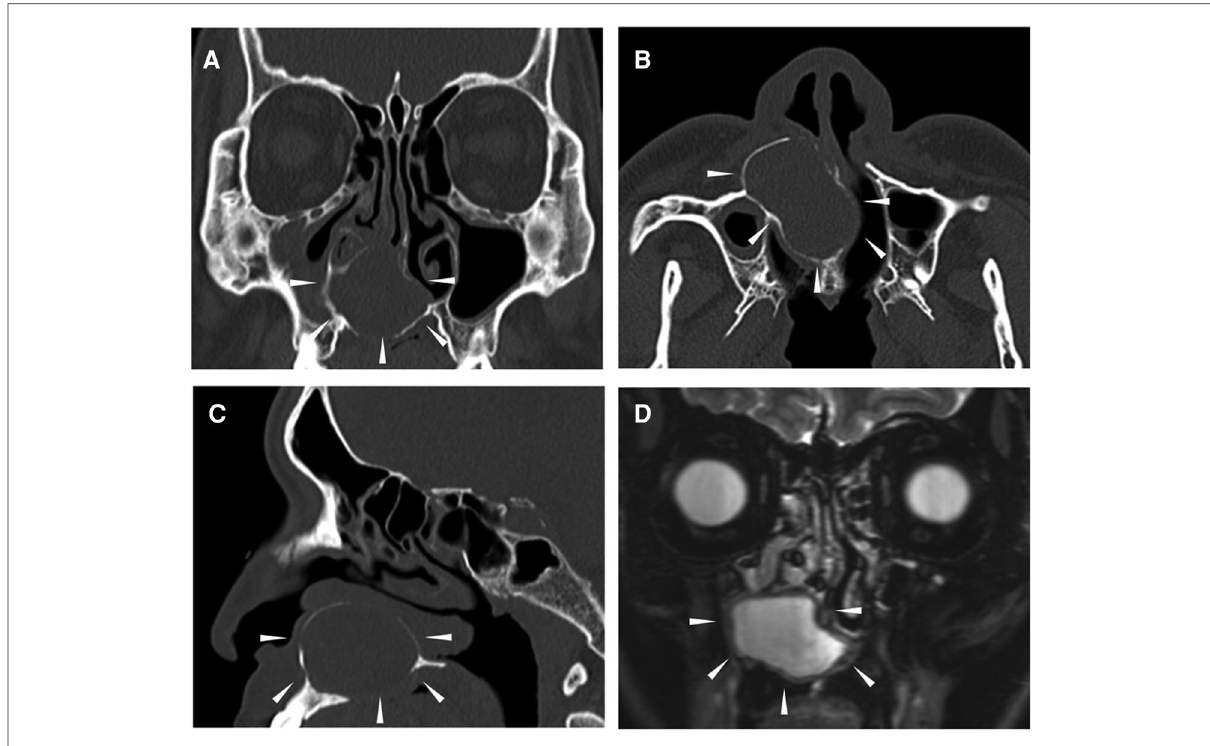
FIGURE 1 Preoperative CT scans and T2-weighted MRI of the sinuses. The area surrounded by the arrowhead indicates the lesion. ( A ) Coronal CT, ( B ) Axial CT, ( C ) Sagittal CT, and ( D ) T2-weighted MRI. CT, computed tomography; MRI, magnetic resonance